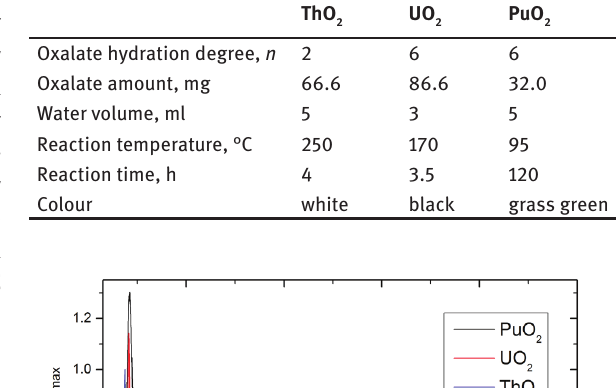
Table 1: Typical reaction conditions for the synthesis of An O obtained through the hydrothermal decomposition of actinide(IV)